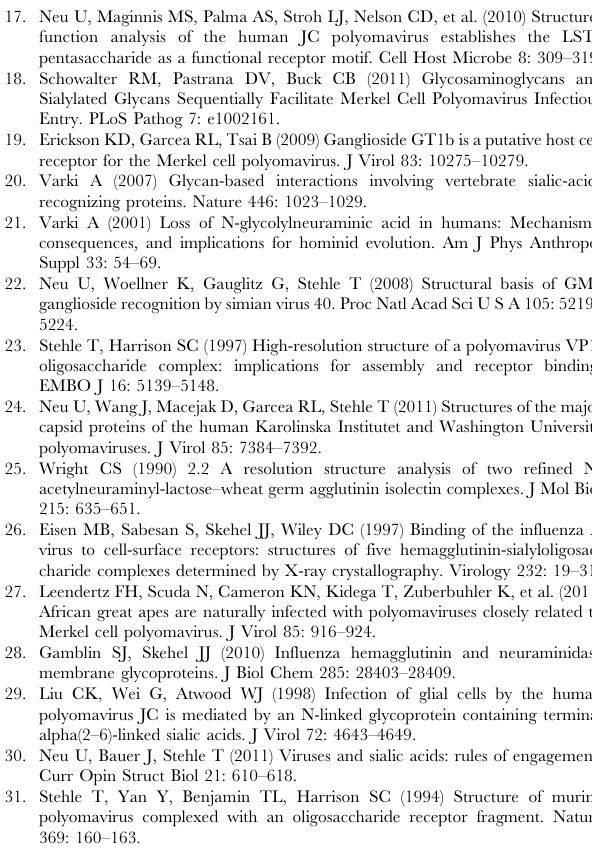
at 2.5 s and displayed 3.5 A˚ around the oligosaccharide ligands. In D, a simulated annealed omit electron density map, contoured at 0.7 s , is shown in addition to the difference map and colored light green. Here, both maps are displayed 15 A˚ around the oligosaccharide ligand. The density in the lower part of the panel corresponds to the MCPyV VP1. Glycosidic linkages to other monosaccharides are shown as black arrows. The red arrow denotes absent electron density for a branch, indicating a non- branching Gal residue. The protein is shown in cartoon representation and colored grey, with one monomer highlighted in cyan. The carbohydrates are shown in stick representation. Nitrogen and oxygen atoms are colored blue and red, respectively, and carbon atoms are colored orange for 3SLN (A), light orange for DSL (B) and yellow for GD1a (C,D). Figure S2 Alignment of receptor-binding VP1 sequences from MCPyV isolates and MCPyV-like viruses from chimpanzees. Complete VP1 sequences were retrieved from GenBank and aligned with Muscle. Identical residues are indicated with an asterisk. Residues contacting carbohydrate are shaded dark teal if identical and light teal if not identical. Figure S3 Additional 1 H-NMR-Spectra of MCPyV VP1 and DSL. (A) DSL reference. (B) DSL STD spectrum with MCPyV VP1. (C) TOCSY spectrum of internal Neu5Ac ring displaying H3-H6 resonances which also appear in the STD spectrum (vertical lines). (D) TOCSY spectrum of terminal